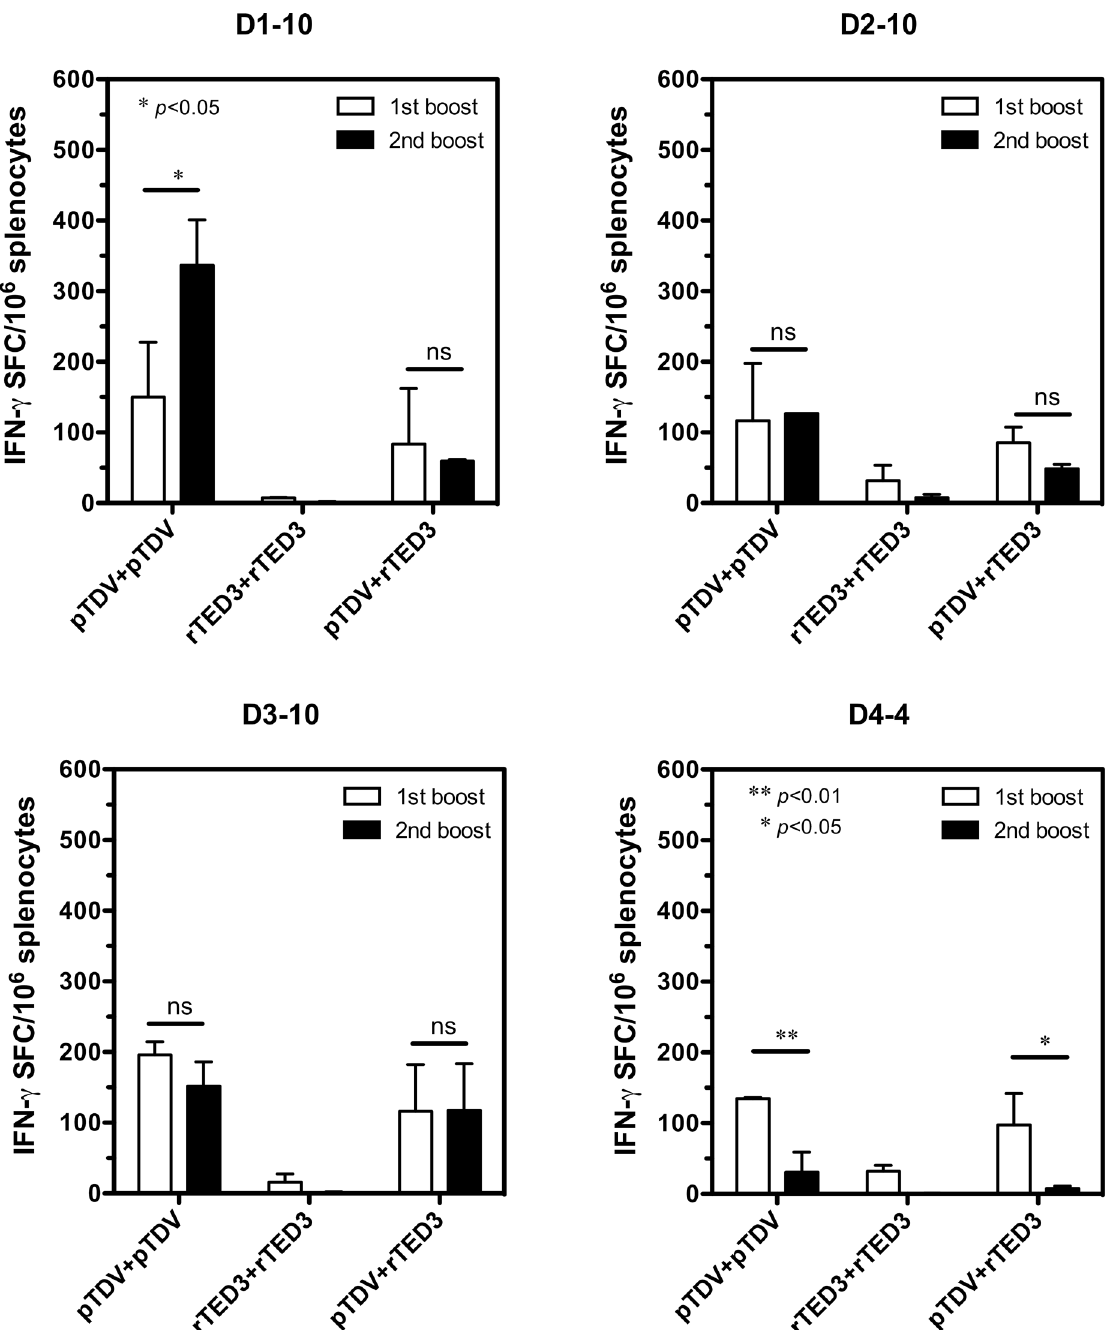
Fig 5. The time-course changes in CD4 + T-cell epitope-specific responses after tetravalent dengue vaccination. Groups of 6- to 8-week-old BALB/c female mice (n = 4) were immunized three times at 2-week intervals with pTDV-ED3, rTED3 or prime-boost as indicated in Fig 2. Spleen cells from two mice per group were harvested one week after either the 1 st or 2 nd boost for the detection of IFN- γ production by ELISPOT. The mean and SD of SFC per million splenocytes responding to stimulation with the indicated individual peptides are